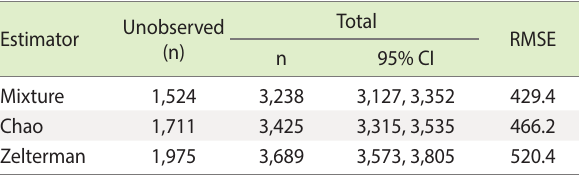
Table 2. Number of attempted suicides by deliberate self-poisoning using the truncated count model